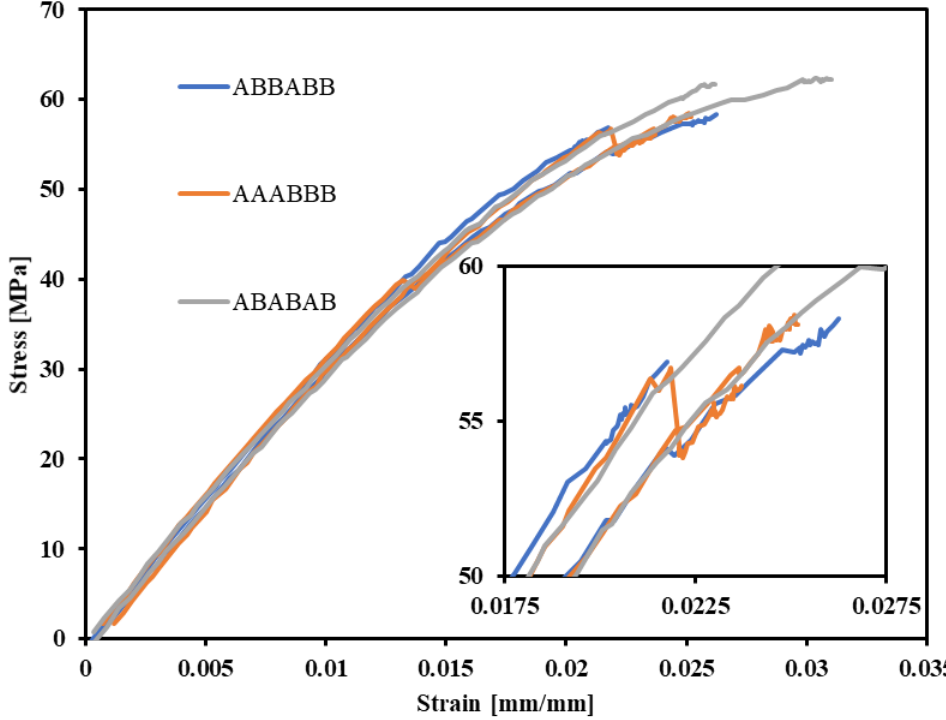
Figure 11. Tensile testing data for all multi-material A—ULTEM 9085 + B—ULTEM 9085CF specimens. Magnification of strain near fracture is shown in the inset.